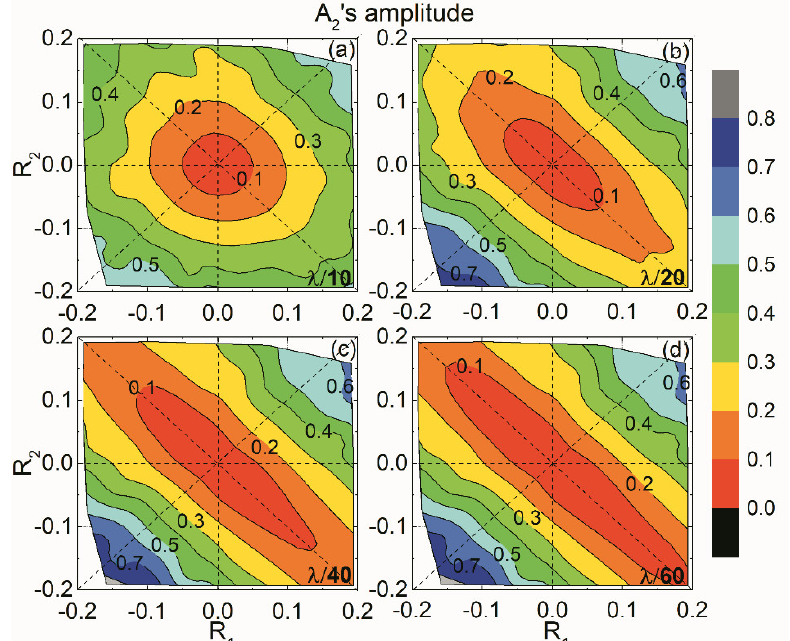
Figure 12. A 2 ’s amplitude of 120 thin-bed models with different thickness, R 1 or R 2 .